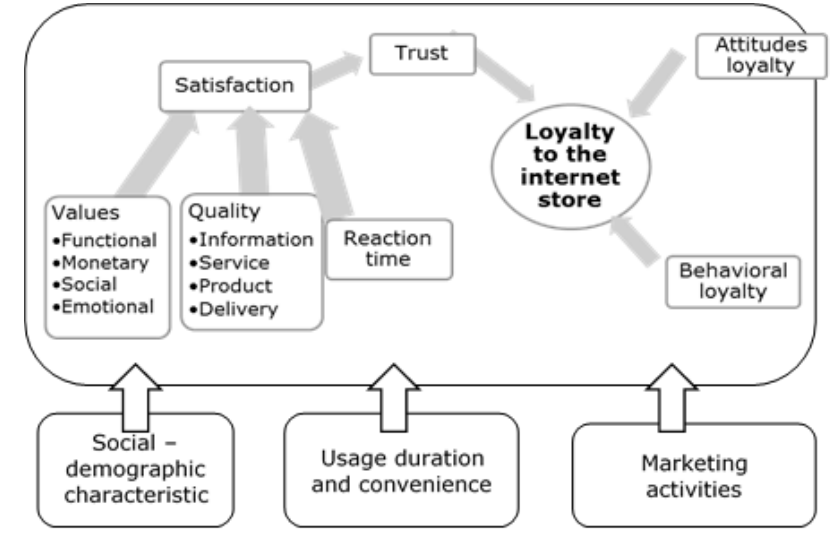
Fig. 2. Consumer loyalty model to the internet store (Developed by